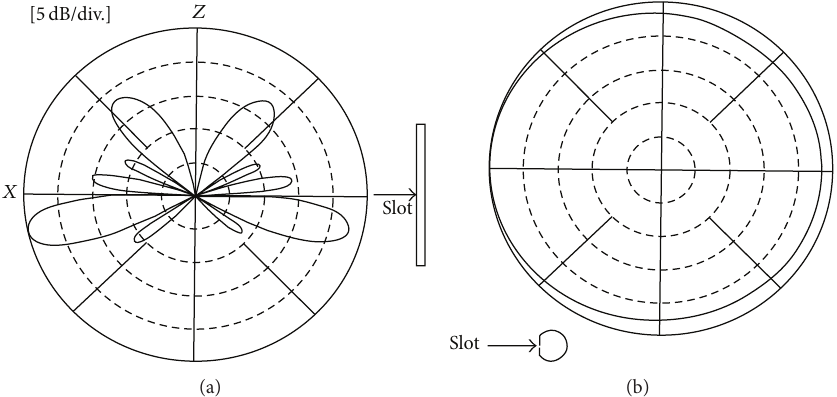
Figure 9: Measured radiation patterns of the four-element DSCA array with beam tilt (H tilt antennas). (a) Vertical plane. (b) Conical